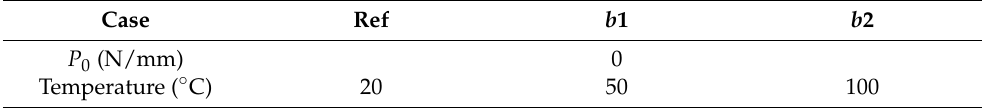
Table 6. Different cases set of thermal loads.